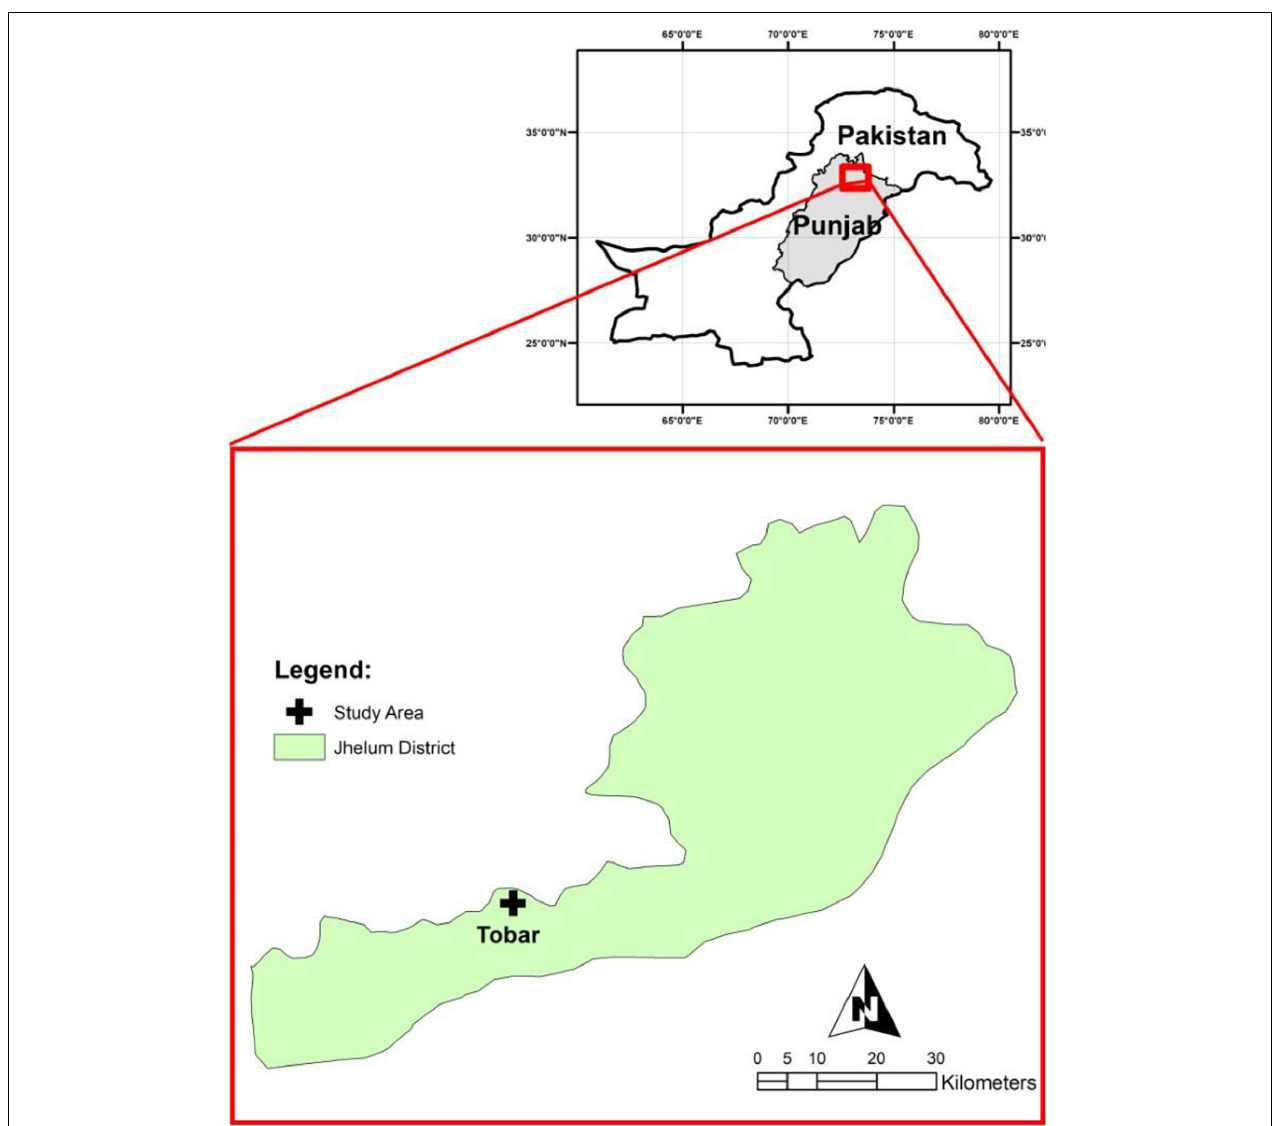
FIGURE 1 | The location of study site in the Tobar area, Punjab,